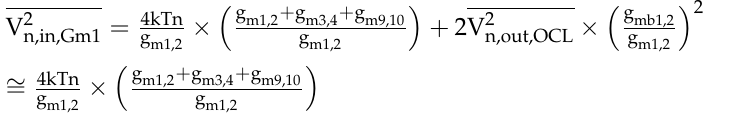
Figure 7. Schematic of the two-stage OTA G m3 in A-OCL.